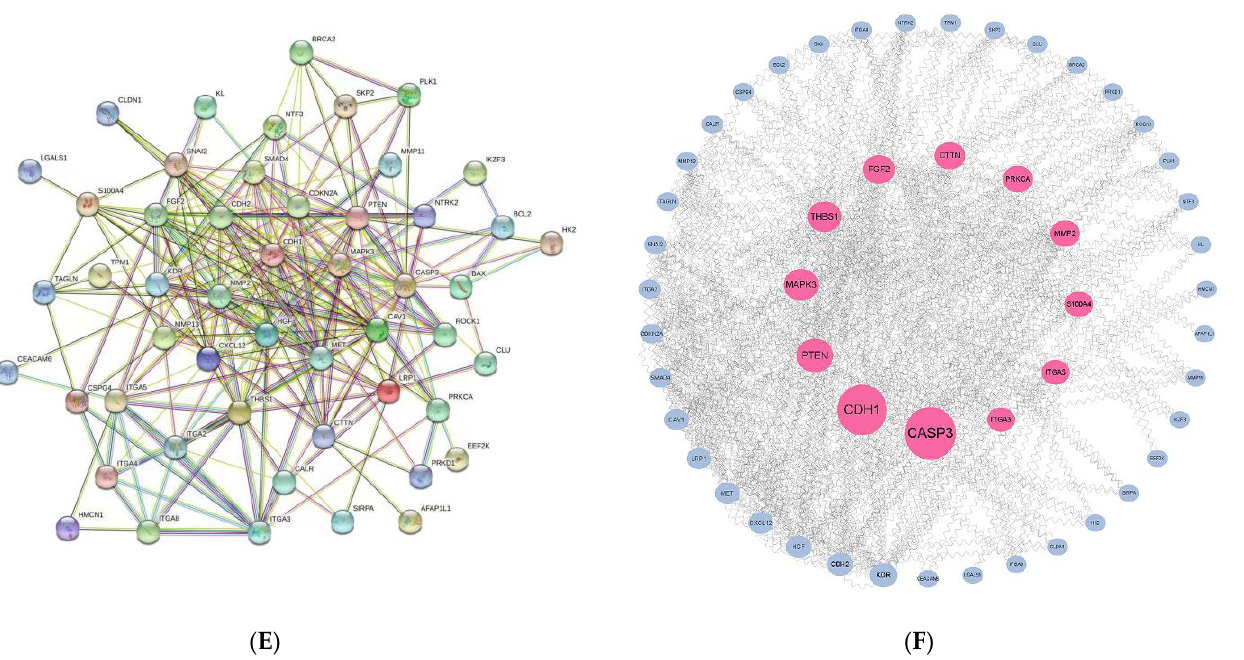
Figure 2. Functional enrichment of the differentially expressed ANRGs. ( A ) A bubble plot of the Gene Ontology (GO) enrichment analysis. ( B ) A circle plot shows the important signal pathways that were correlated with these genes. ( C ) A Kyoto Encyclopedia of Genes and Genomes (KEGG) signal pathway enrichment analysis. ( D ) The genes that were identified through the Gene Set Enrichment Analysis (GSEA). ( E , F ) Protein – Protein Interaction (PPI) analysis of the differentially expressed ANRGs.